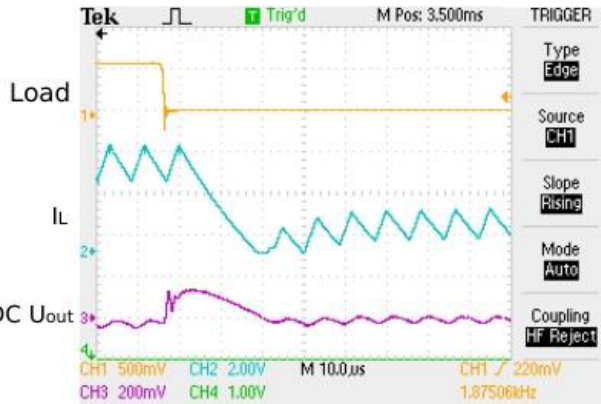
Figure 10. Step decrease in output current